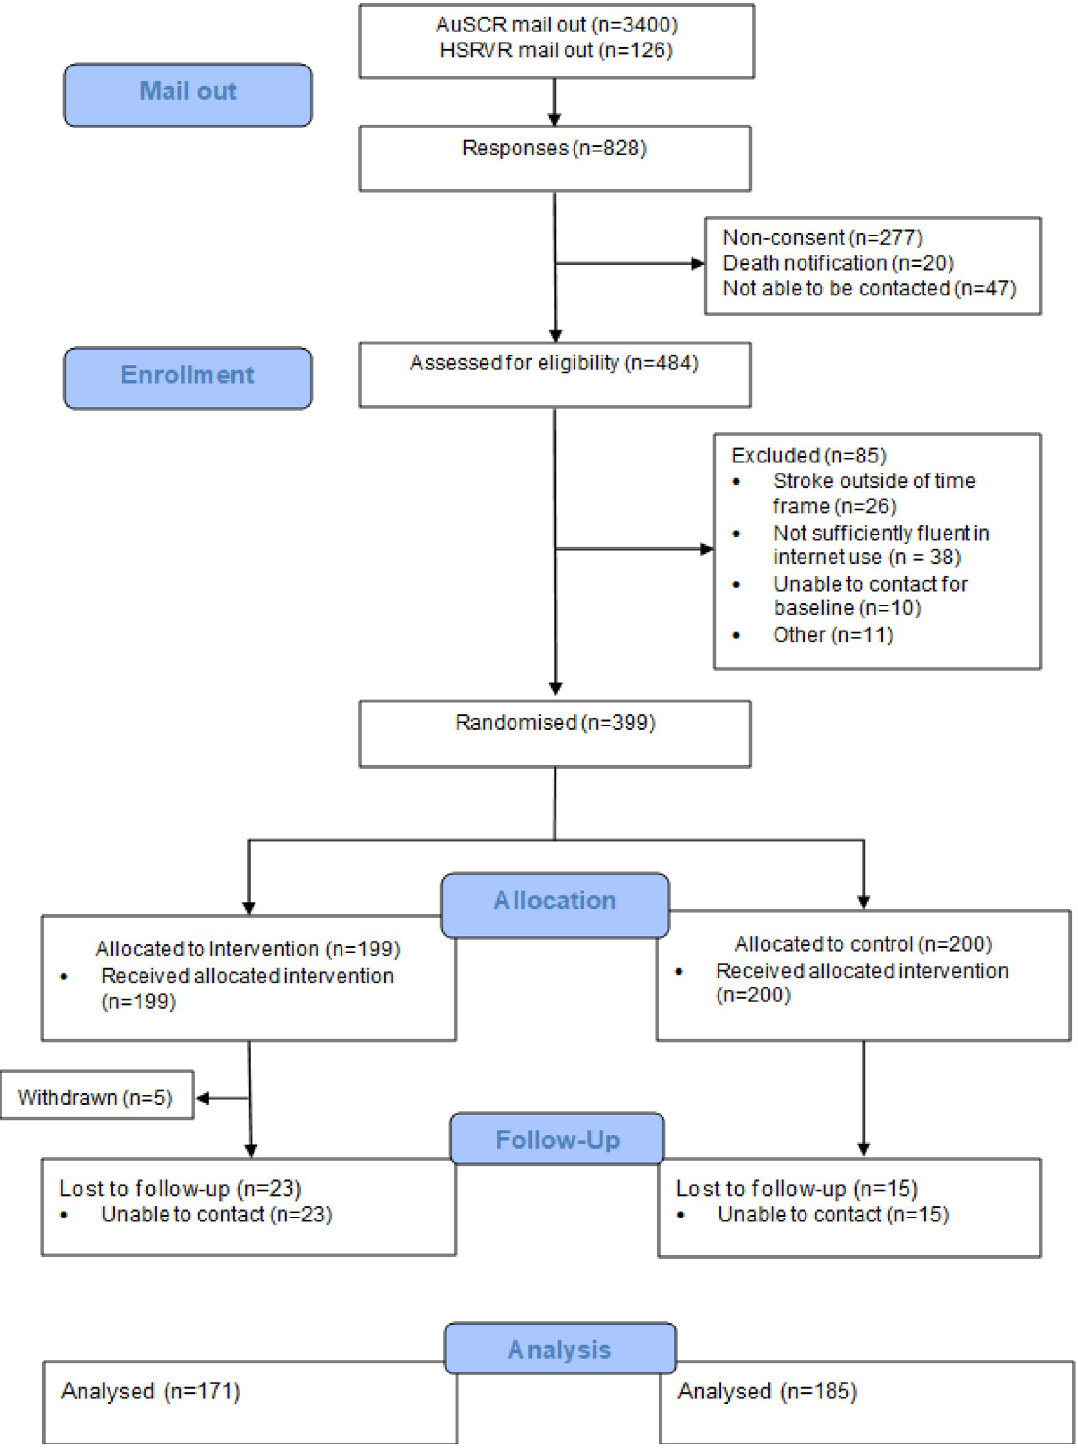
Fig 1. Study CONSORT flow diagram.AuSCR, Australian Stroke Clinical Registry; HSRVR, Hunter Stroke Research Volunteer Register.